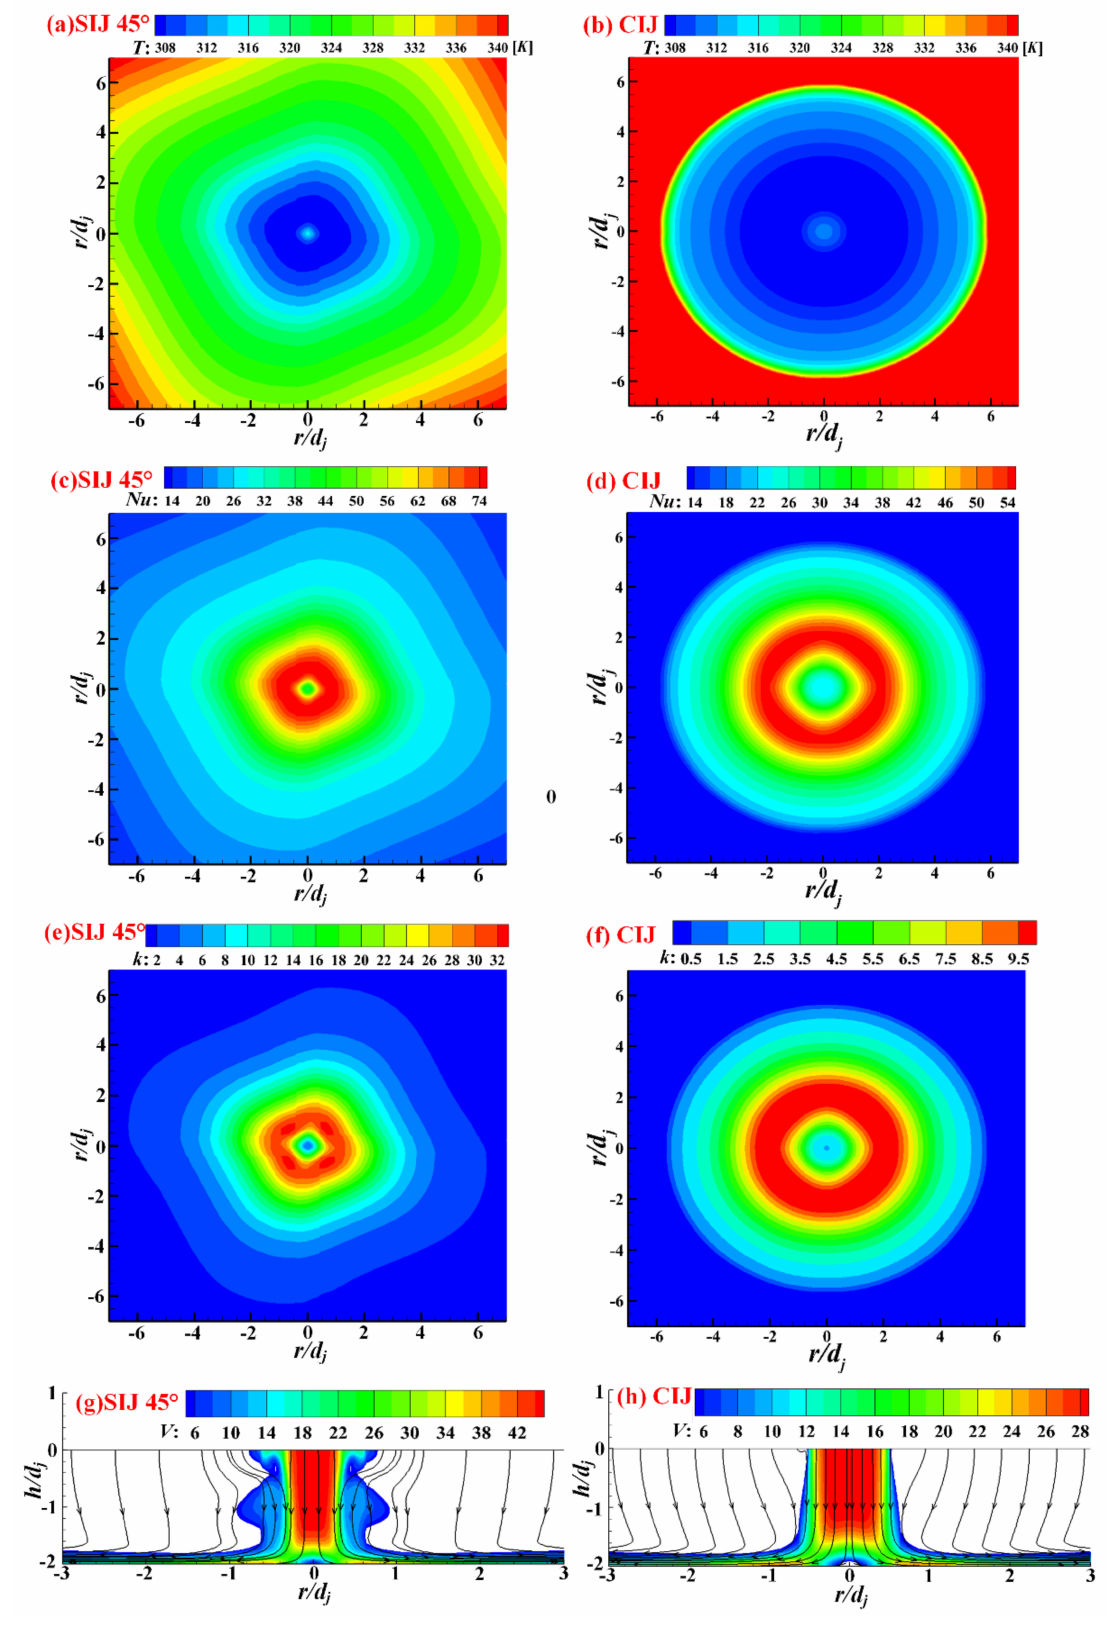
Figure 13. Comparison of SIJ 45 ◦ and CIJ: ( a , b ) temperature distribution, ( c , d ) Nu distribution, ( e , f ) turbulent kinetic energy ( k ) distribution, and ( g , h ) streamlines and velocity contours in x = 0 section ( Re = 12,000 and h/d j =